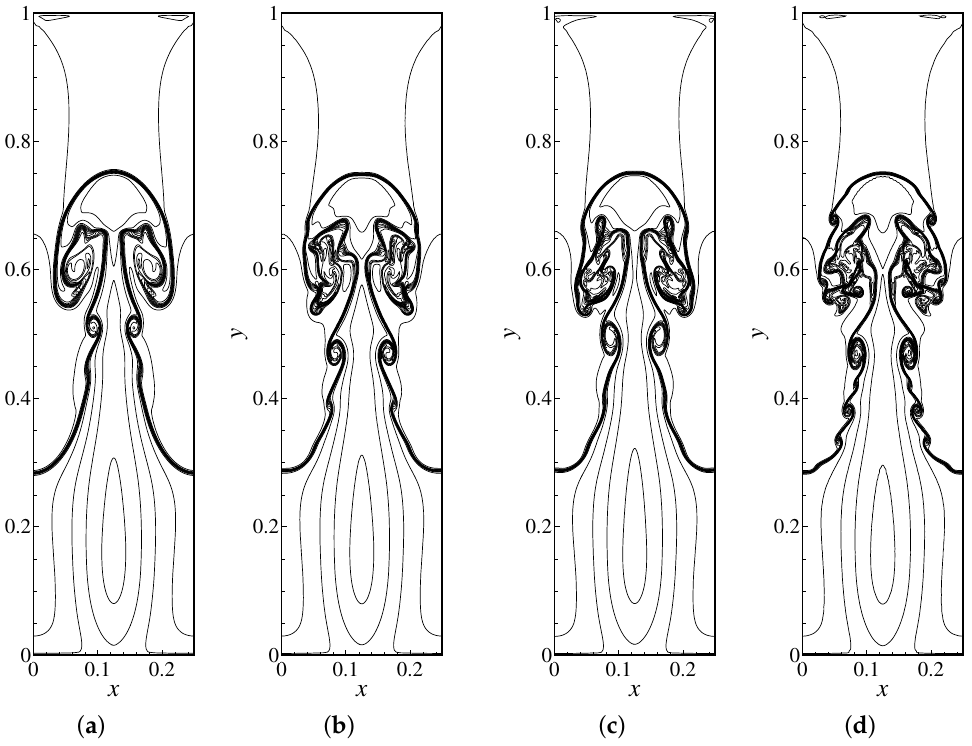
Figure 18. Density contours of the Rayleigh-Taylor instability problem with 241 × 961 grid points. 14 equally distributed contours ranging from 0.9 to 2.2: ( a ) WCNS5-JS; ( b ) WCNS5-Z; ( c ) WCNS5-AS; ( d )